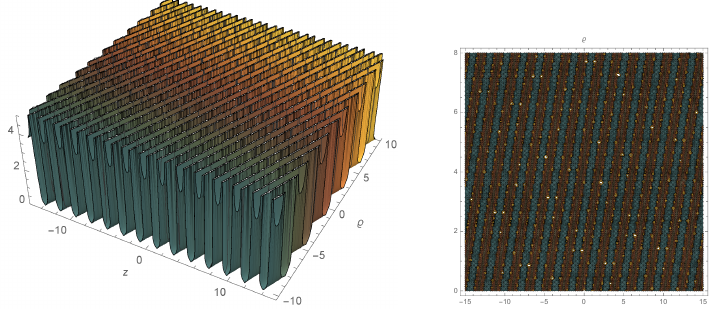
Figure 4. Three-dimensional (3D) and contour plots of the periodic solution of Equation